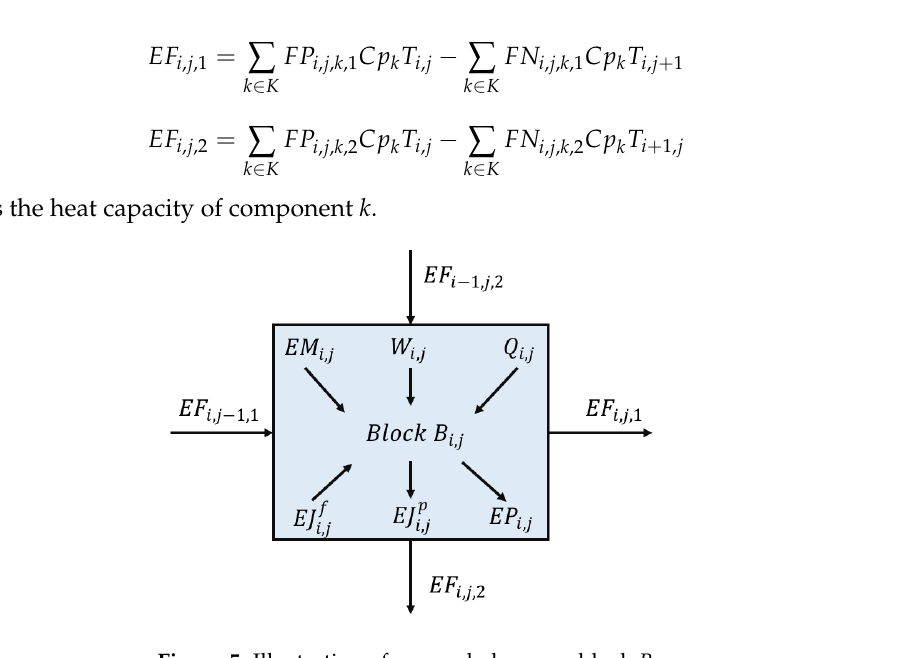
Figure 5. Illustration of energy balance on block B i , j